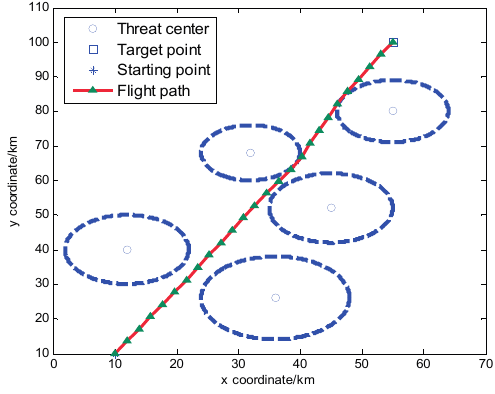
Figure 7. Result of the first instance for D = 25.